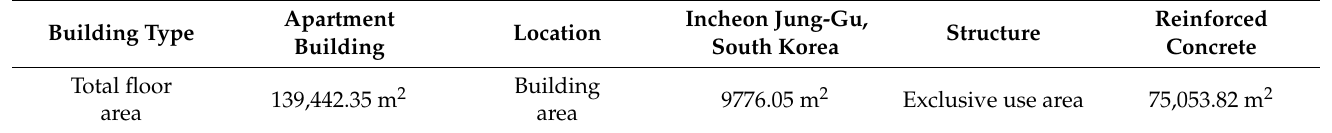
Table 5. Case study